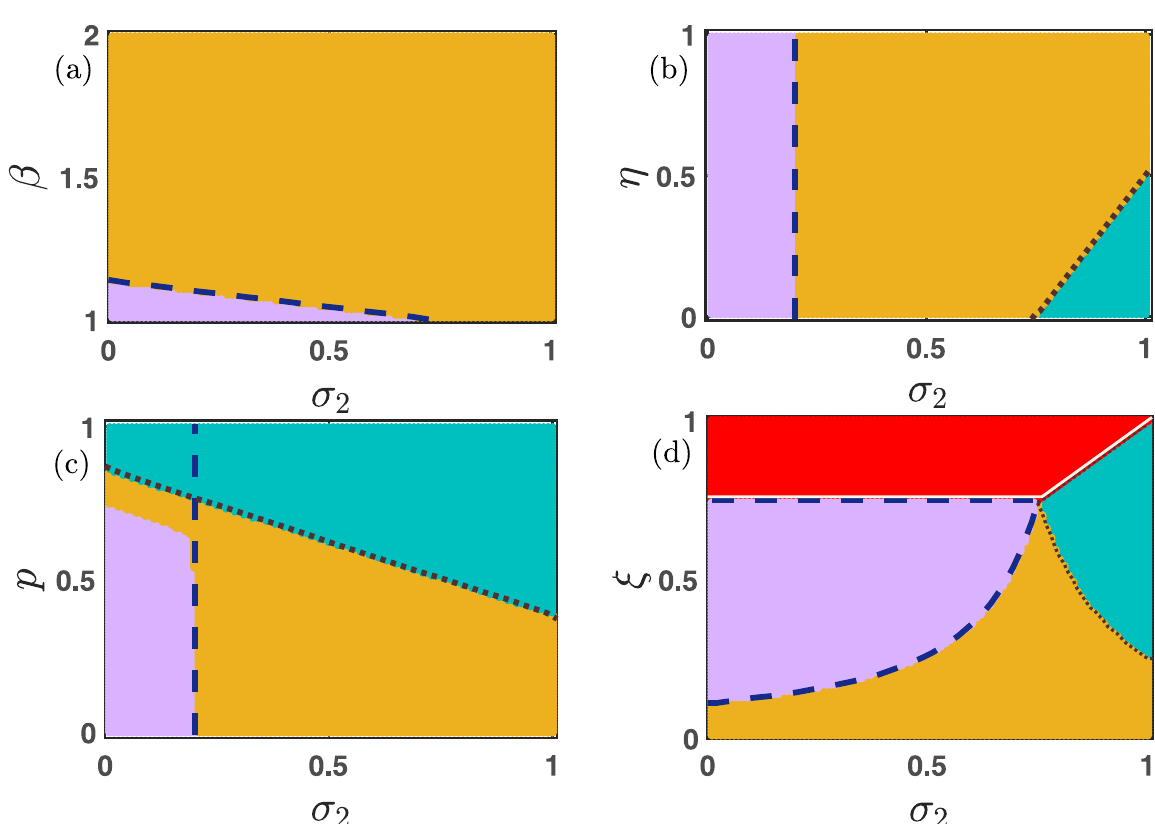
Fig 5. Investigating the impact of σ 2 on the evolution of cooperation. For the smaller values of σ 2 , the mutation-free system gives rise to the defector-free (violet region) society. While larger values of σ 2 encourage the defectors and stabilize the cooperator-free stationary point E 2 (sea blue region). Suitable choices of parameters may favor the co-existence of cooperators as well as defectors. Even for a higher mortality rate ξ ’s values, all individuals die in the red portion of the parameter space σ 2 − ξ in subfigure (d). All the parameters are set at ξ = 0.15, η = 0.85, β = 1.1, p = 0.30, σ 1 = 0.75, and μ = 0, unless it is varied. The simulations are computed for 20 × 10 5 iterations with fixed initial condition ( x 0 , y 0 ) = (0.35, 0.35). The color codes are as follows: (i) red represents the extinct state E 0 , (ii) yellow represents the co-existence state E 3 , (iii) violet represents the defector-free state E 1 , and (iv) sea blue represents cooperator free state E 2 , respectively. We plot the stability curves corresponding to each stationary point in each subfigure.